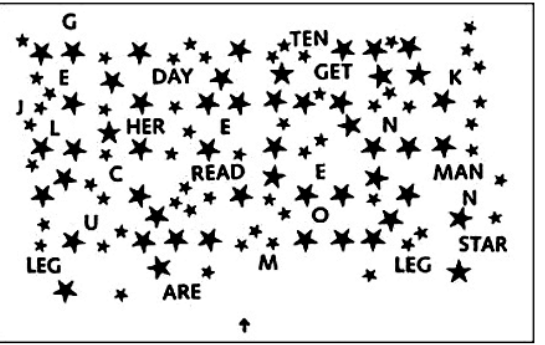
Figure 3. For the star cancellation test, all the stars have to be indicated. The difference in missed stars between the left and right side indicates potential